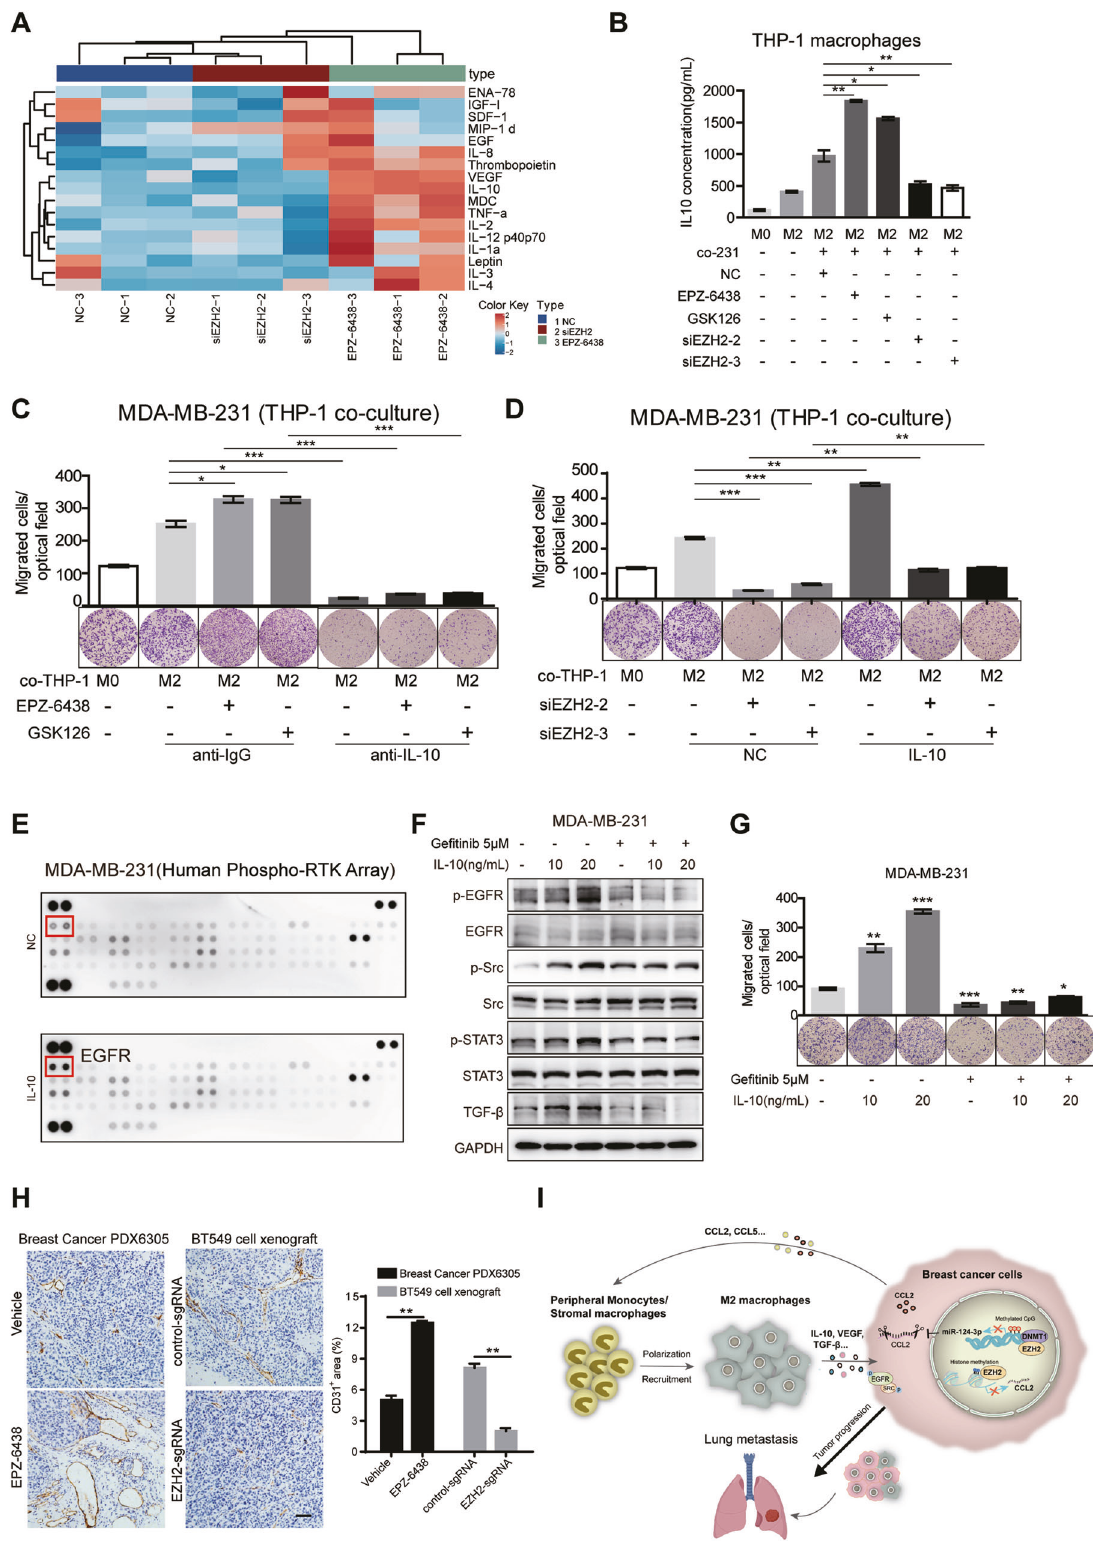
TAMs co-cultured with murine glioblastoma cells [54, 55]. But another paper pointed out that the EZH2 inhibitor GSK343 induced the transformation of M1 macrophages into M2 macro- phages [56]. In addition, EZH2 has been shown to enhance the